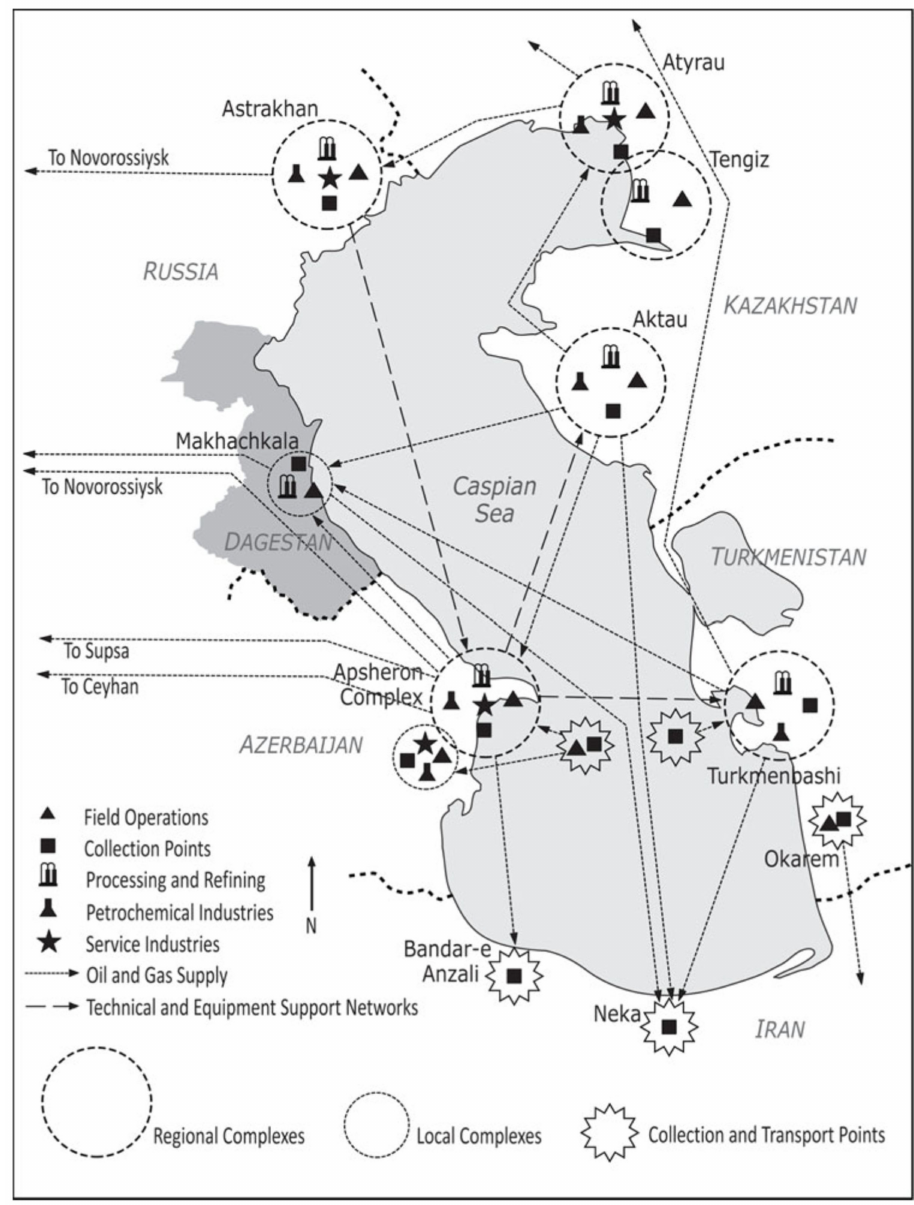
Figure 2. Diagram of the Caspian gas-oil complex [24] (p.